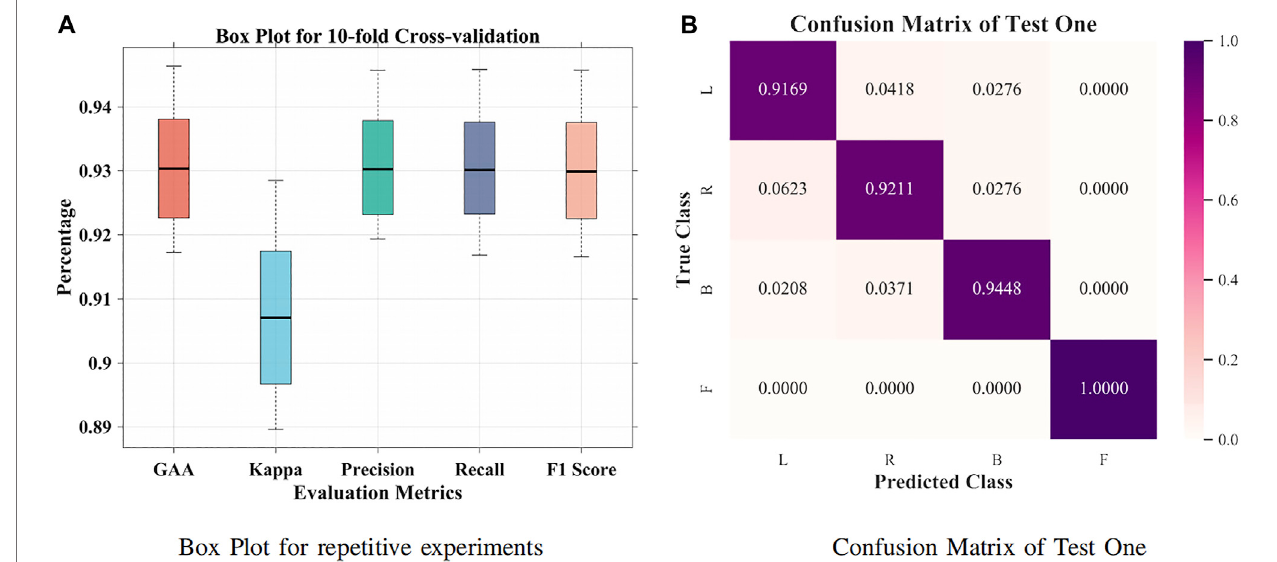
FIGURE 5 | Box plot and confusion matrix for 10-fold cross-validation. (A) Box plot for repetitive experiments. (B) Confusion matrix for test one.